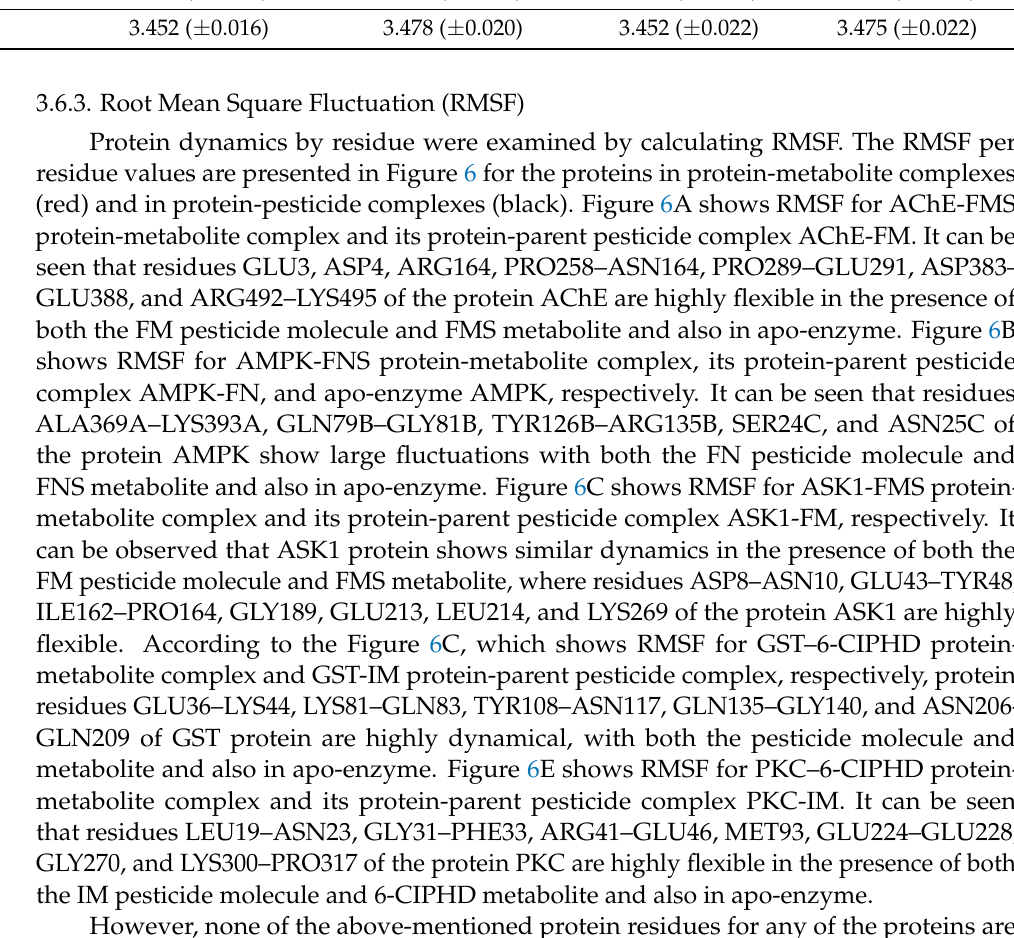
Table 3. Radius of gyration of the crystal, protein-ligand complex, and protein during the MD simulation. Average Rg and Standard Deviation of Protein Rg of Crystal Ligand Complex During MD Simulation Protein Structure of Protein (nm)Metabolite Metabolite Parent Pesticide Metabolite Parent Pesticide